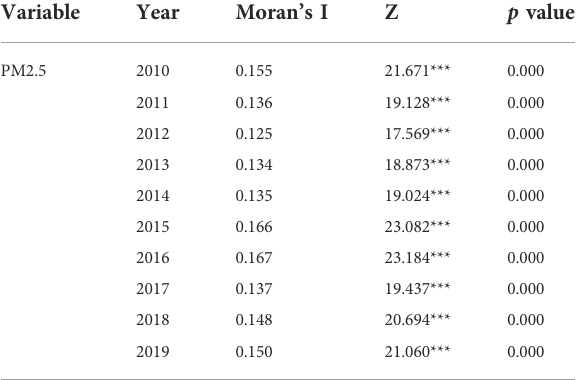
TABLE 2 Moran ’ s I for PM2.5.